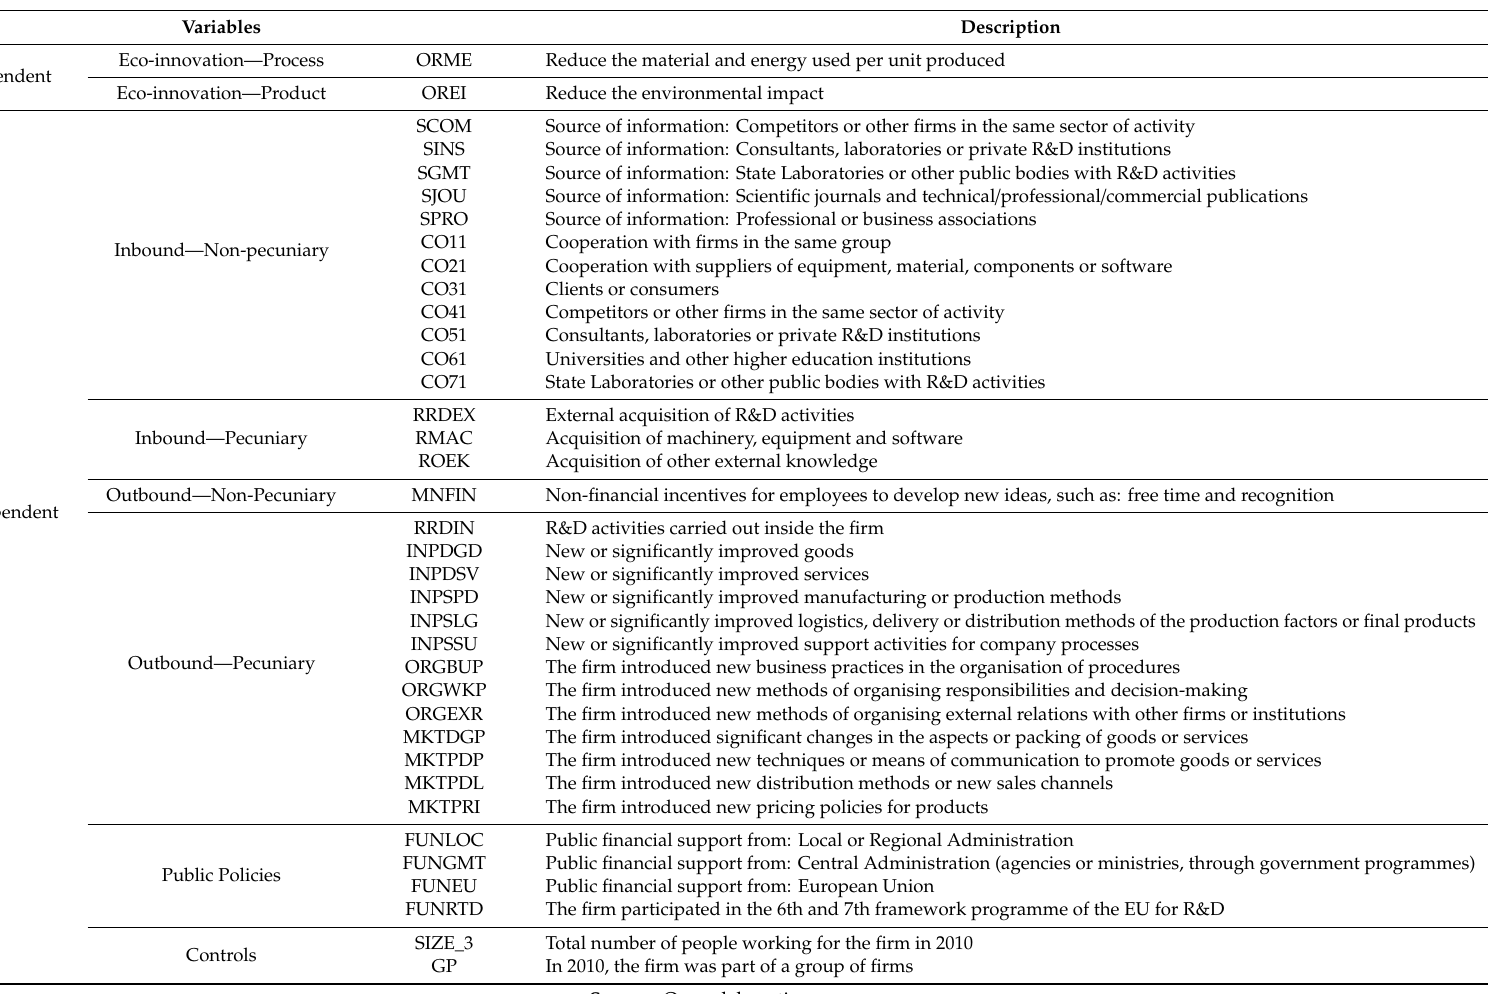
Table 2. Dependent, independent and control